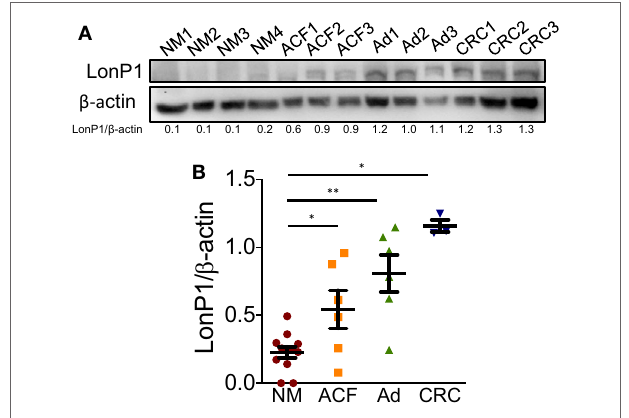
FigUre 1 | LonP1 expression during colon cancer progression. (a) Representative Western blot analysis of LonP1 expression in freshly frozen tissue samples from normal mucosa (NM), aberrant crypt foci (ACF), colonic adenoma (Ad), and colorectal cancer (CRC). (B) Relative protein level of LonP1 in NM, ACF, Ad, and CRC. Data are reported as mean ± SD; * P < 0.05 and ** P <